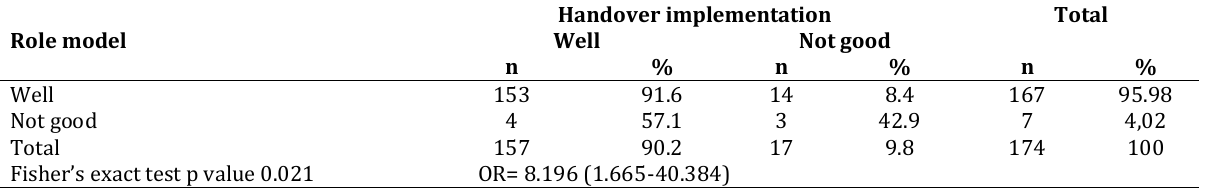
Table 3. Relationship between role models and the implementation of handover in the inpatient ward of Ulin Hospital Banjarmasin Role model